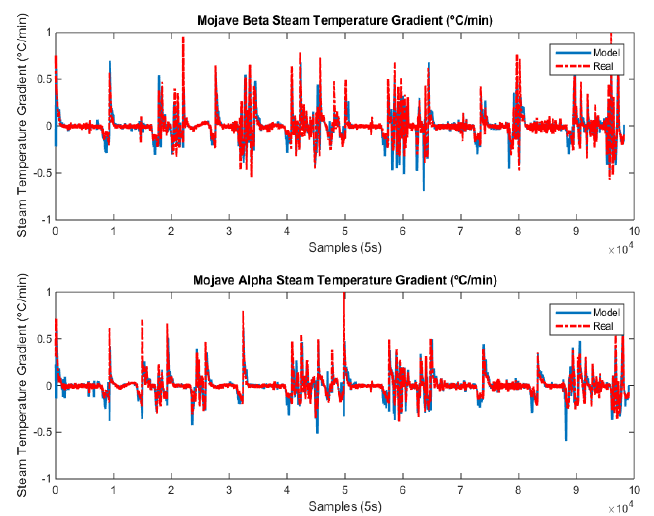
Figure 18. Mojave Beta and Alpha: Steam Temperature Gradient: ( top ) Mojave Beta model, showing real evolution (red dash-dotted) and model output (blue solid); and ( bottom ) Mojave Alpha model, showing real evolution (red dash-dotted) and model output (blue